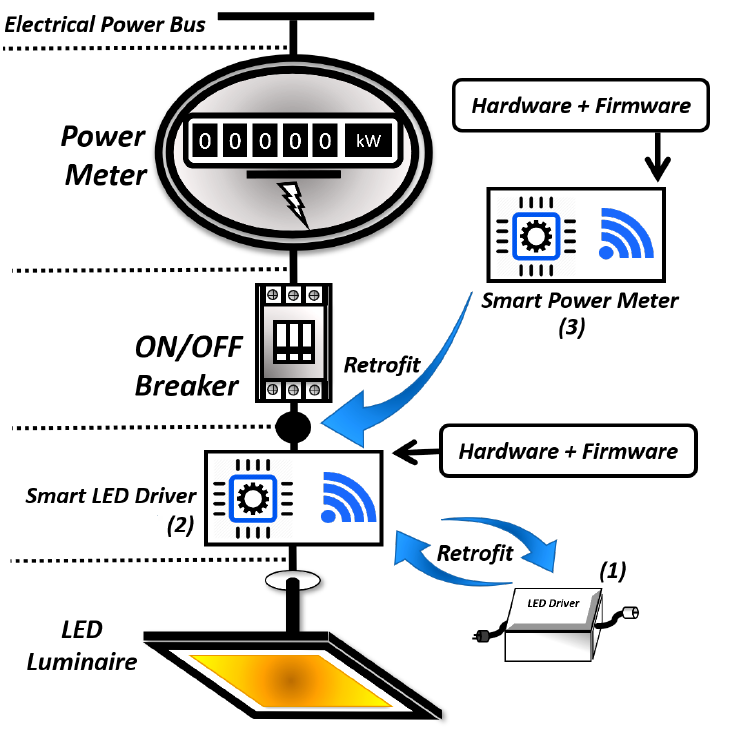
Figure 2. Proposed retrofit strategy for smart building